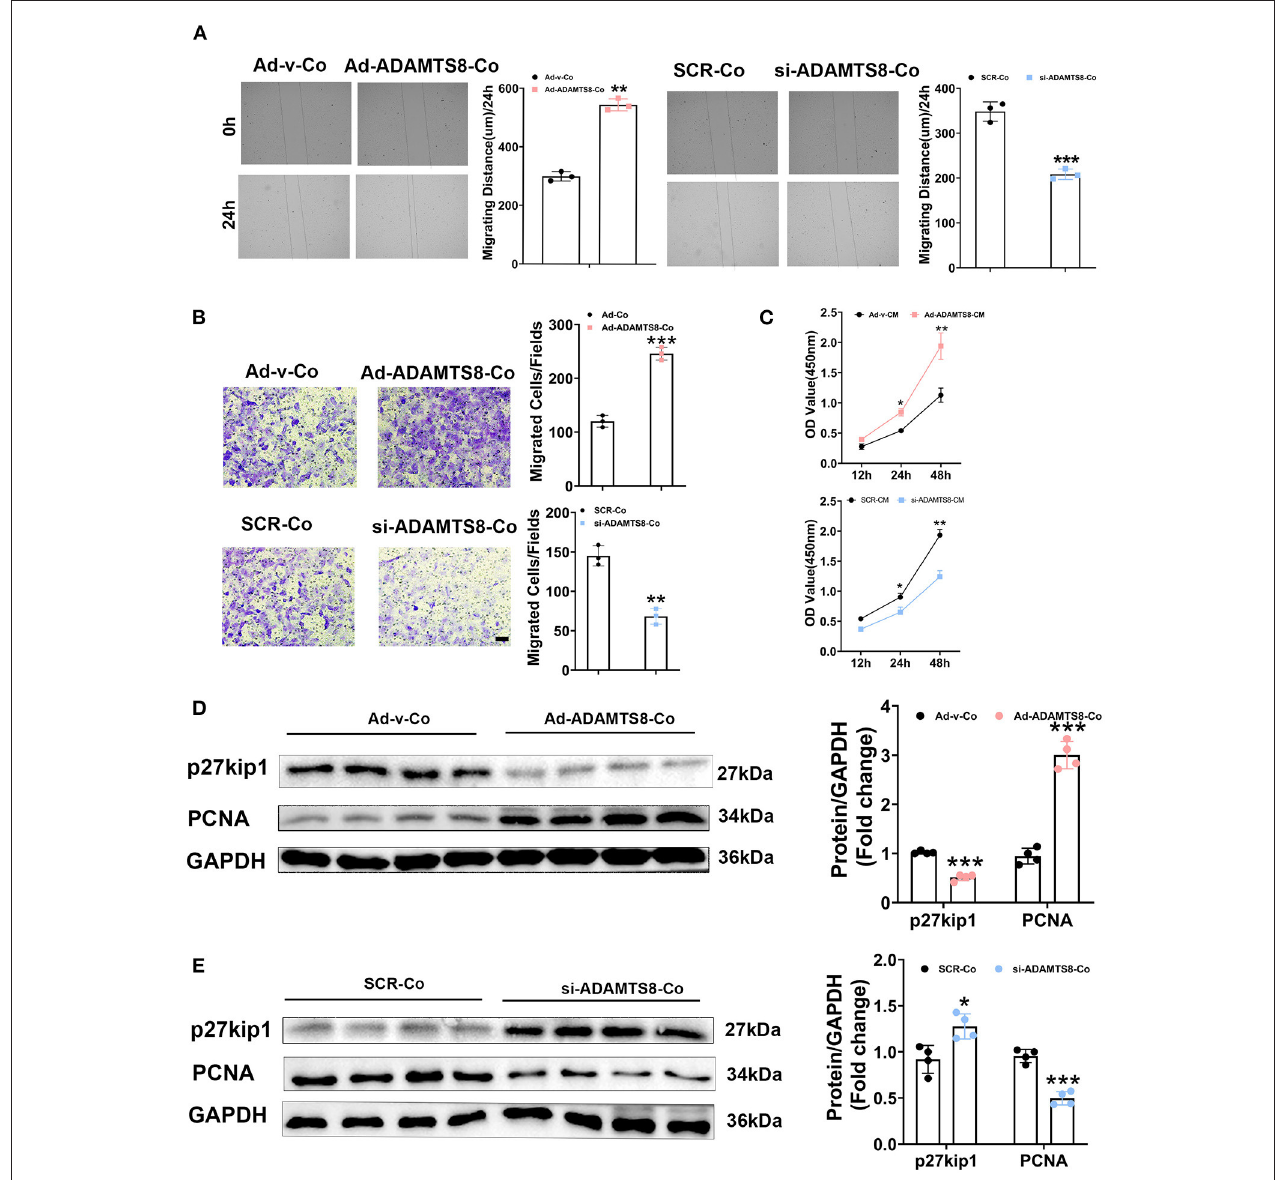
FIGURE 5 | ADAMTS8 mediated the interaction between cardiomyocytes and cardiac fibroblasts. (A) Wound repair assays to assess the migration ability of cardiac fibroblasts co-cultured with cardiomyocytes transfected with ADAMTS8 overexpressing adenovirus (Ad-ADAMTS8-Co) or siRNA (si-ADAMTS8-Co). (B) Transwell migration assay and quantification of migrated cardiac fibroblasts (scale bar = 50 µ m). (C) Quantification by CCK-8 assay ( n = 4 in each group). (D,E) p27kip1 and PCNA levels in cardiac fibroblasts co-cultured with cardiomyocytes transfected with ADAMTS8 overexpressing adenovirus (Ad-ADAMTS8-Co) or siRNA (si-ADAMTS8-Co) detected via western blotting. Data were presented as mean ± SEM. * P < 0.05, ** P < 0.01, and *** P < 0.001 between the two indicated groups.